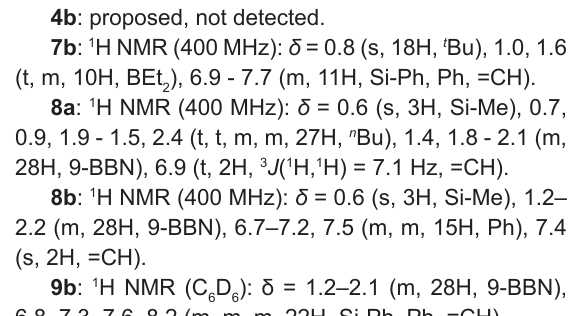
Figure 3. 59.6 MHz 29 Si{ 1 H} NMR spectrum of the mixture containing 10b and 13b . Expansion for the signal corresponding to 10b is given. The corresponding 1 J ( 29 Si, 13 C) and 2 J ( 29 Si, 13 C) coupling constants are listed in square brackets. 13 C satellite signals marked by arrows close to the parent peak may arise due to n J ( 29 Si, 13 C) = 4.5 Hz, n ≥